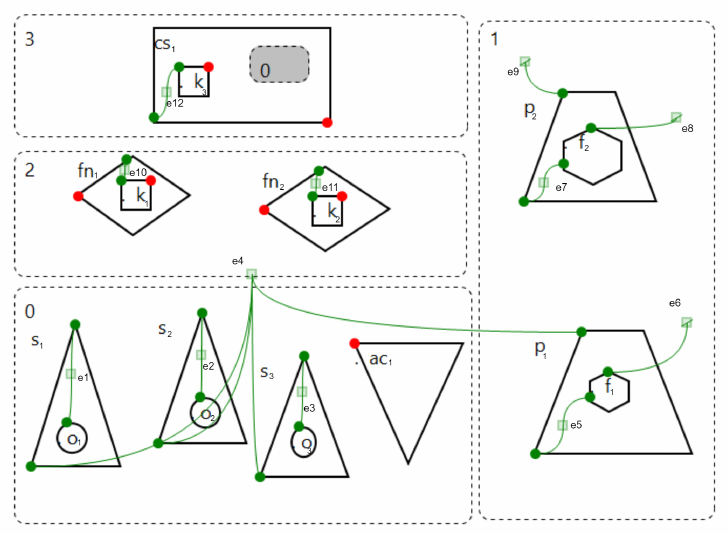
Figure 5. B 0 : The initial bigraph of the LIS physical part model B F